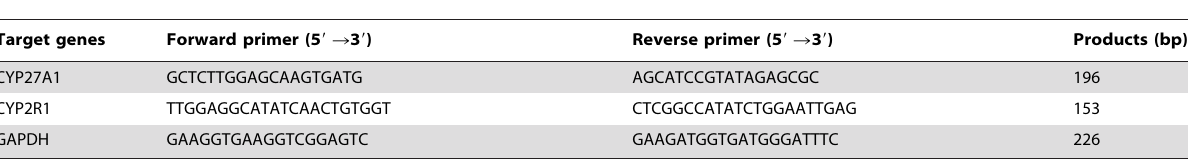
Table 1. Primer sequences used for PCR or real-time PCR.